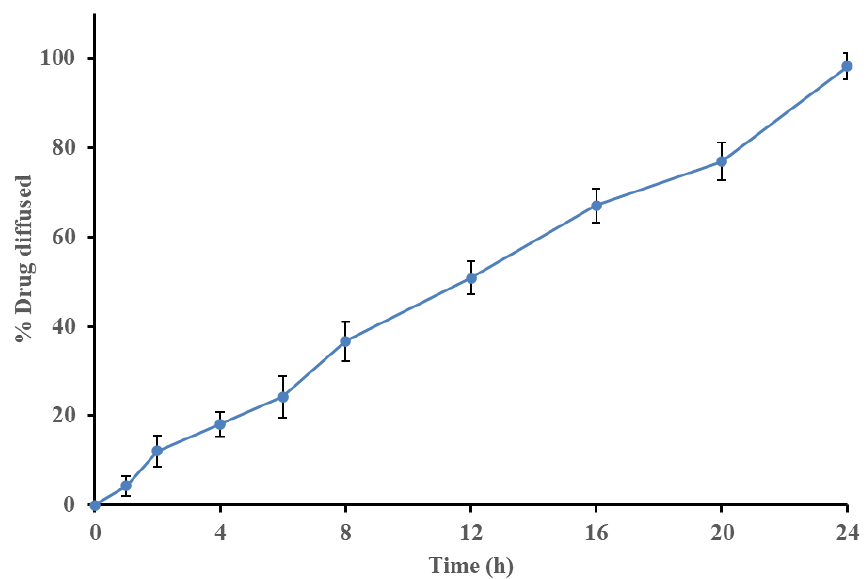
Figure 8. In vitro drug permeation graph of optimized transferosome-loaded proanthocyanidin.